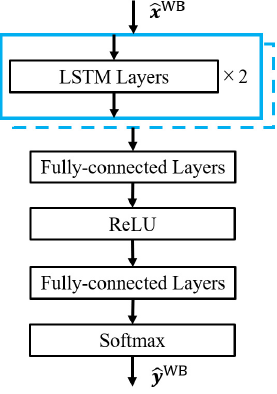
Figure 8. Structure of DNN for high-frequency